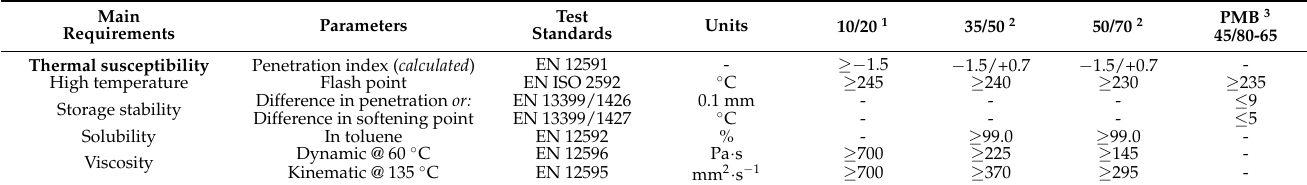
Table 2. Main requirements and standard limits for binders used in this study—additional properties.